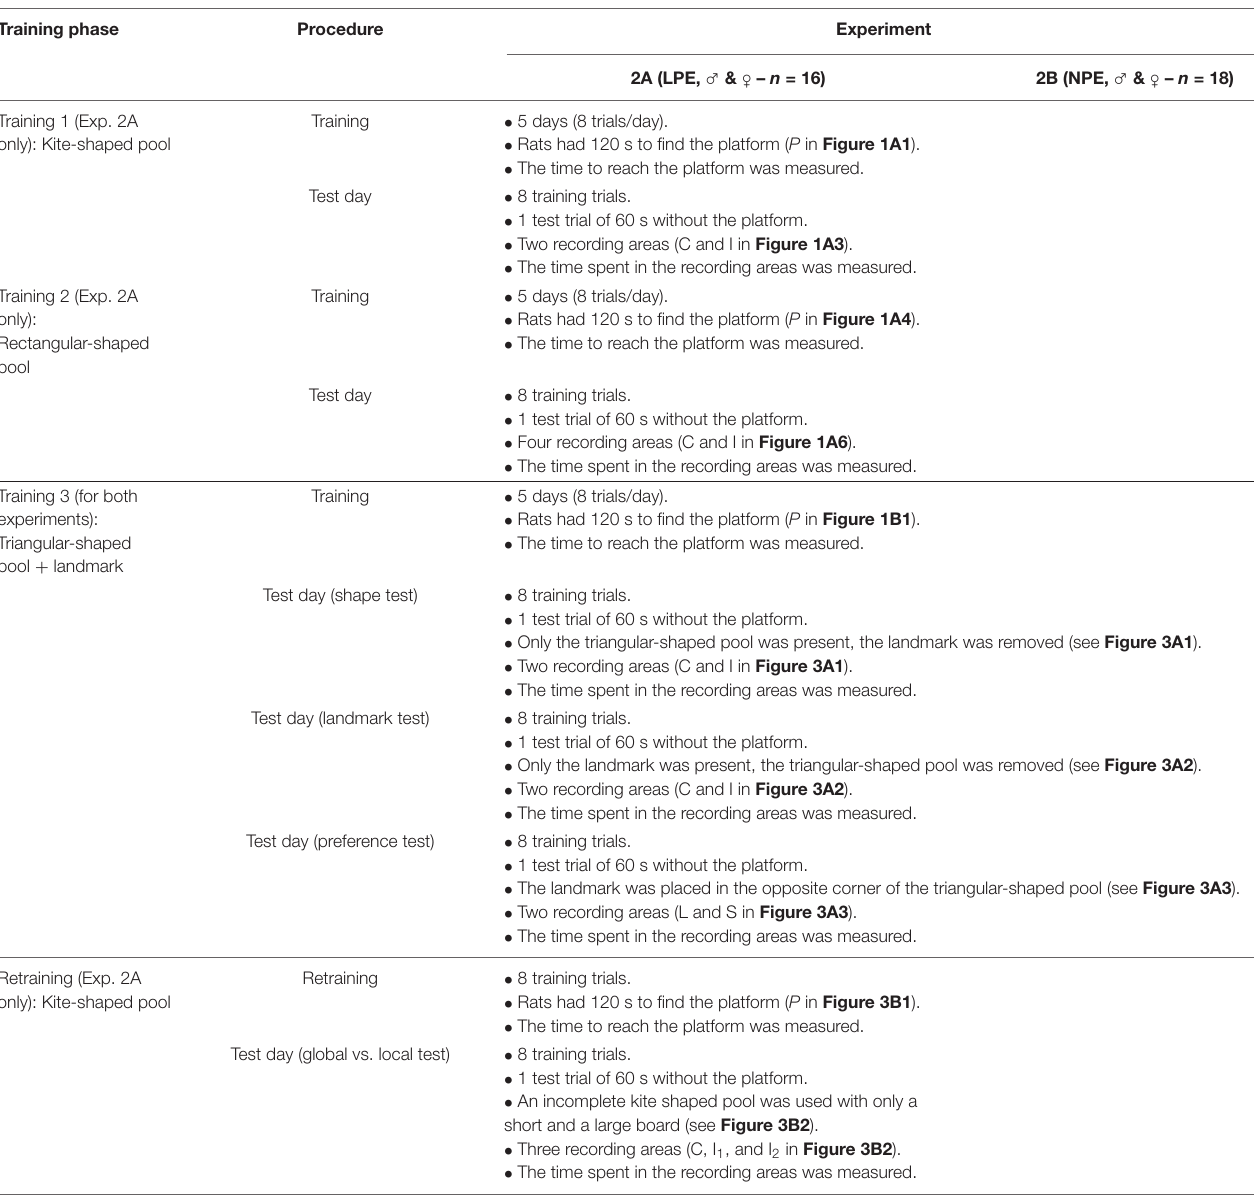
TABLE 4 | Procedure of Experiment 2A ( n =